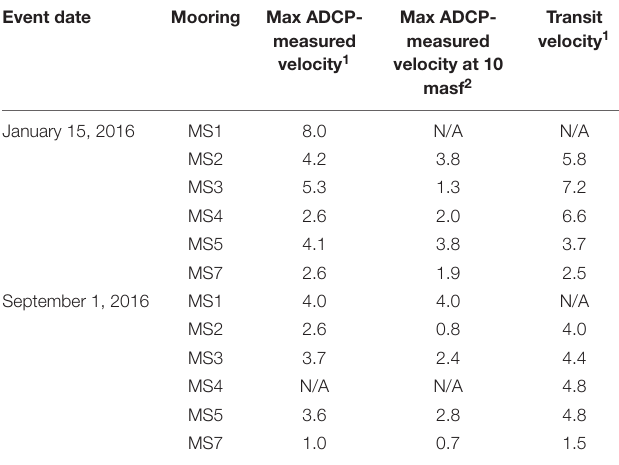
TABLE 2 | Sediment density flow event velocities